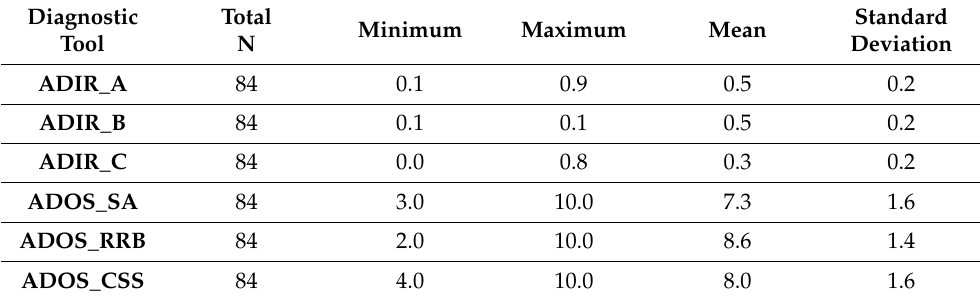
Table 2. The severity of clinical symptoms of ASD group ( n = 84).